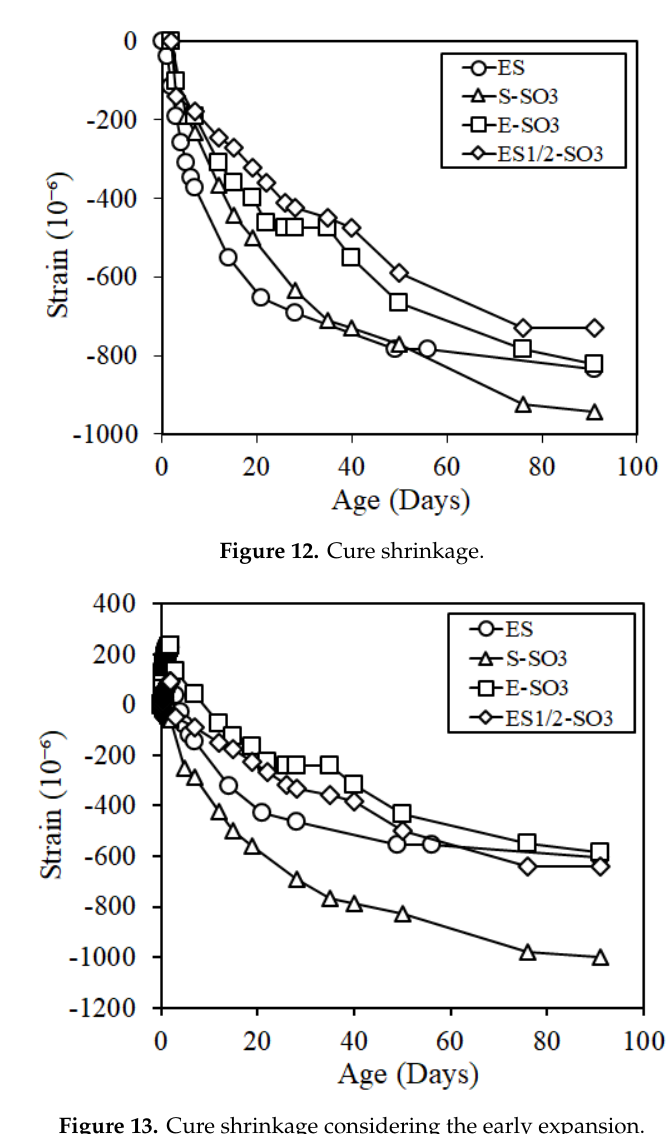
Figure 13. Cure shrinkage considering the early expansion.